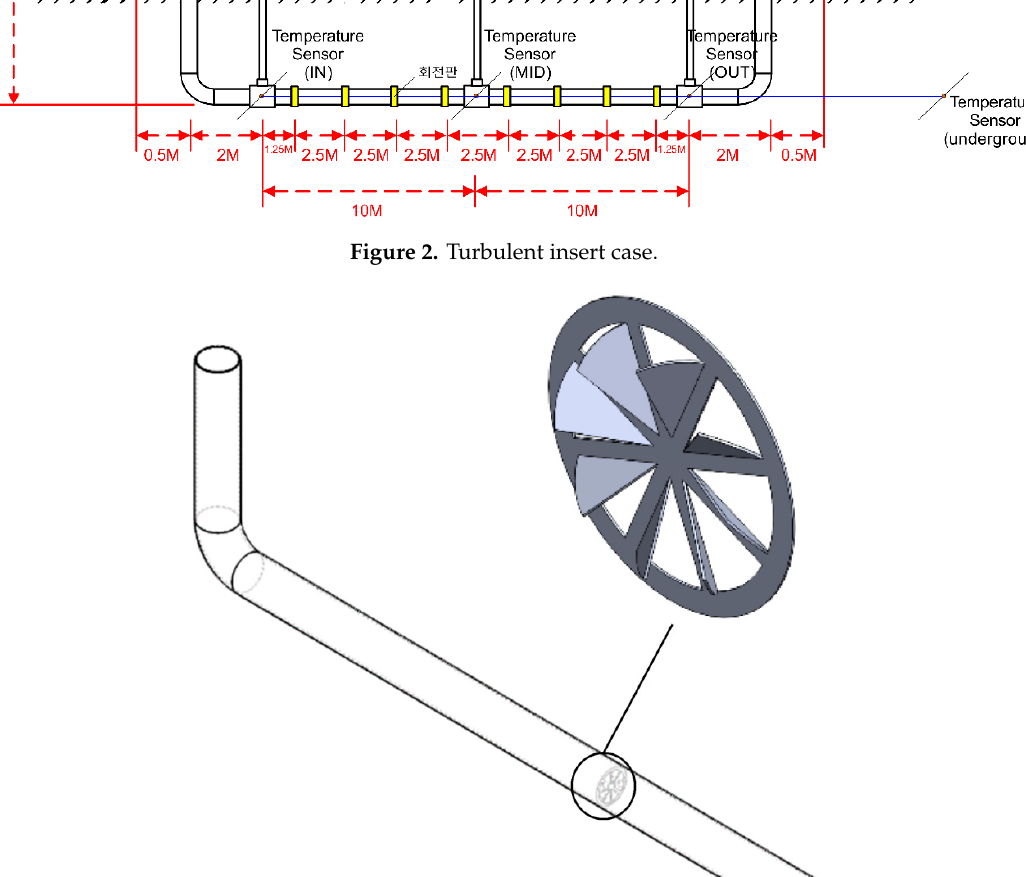
Figure 2. Turbulent insert case.